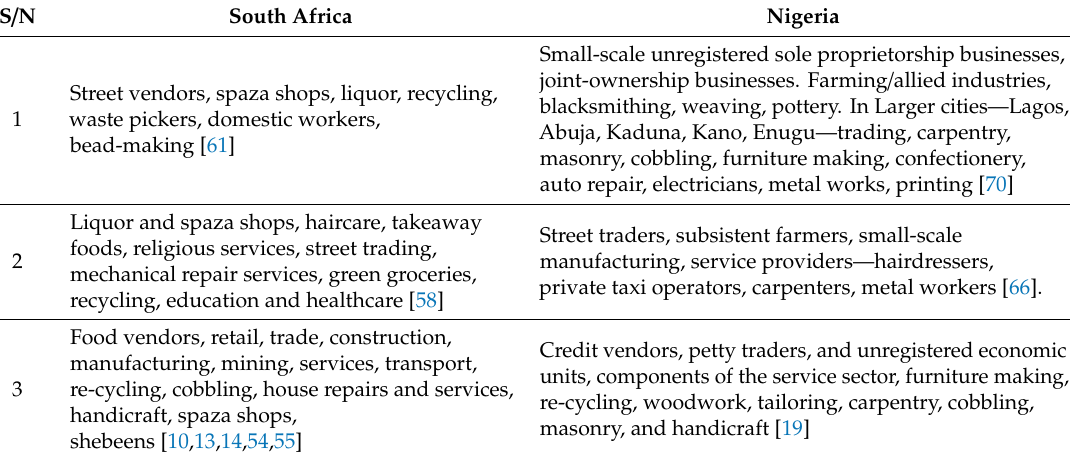
Table 14. Sub-sectors of the informal sector in South Africa and